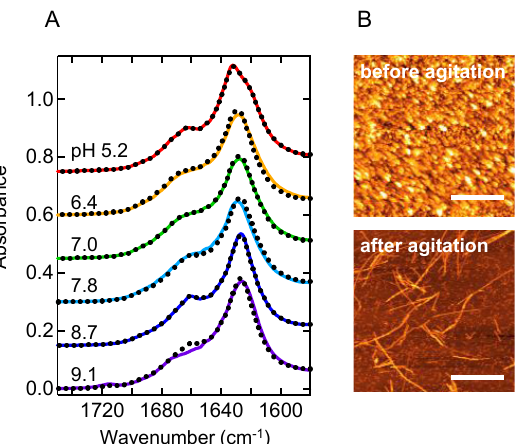
Figure 3. Agitation-induced conversion of nonfibrillar aggregates to amyloid fibrils. ( A ) ATR-FTIR absorption spectra of nonfibrillar aggregates measured after subjected to agitation. The spectra of amyloid fibrils formed under agitated conditions (the same spectra shown in Figure 2) are overlaid with dotted lines for references. ( B ) AFM images at pH 5.2 before and after agitation. Scale bars represent 1 μ m.